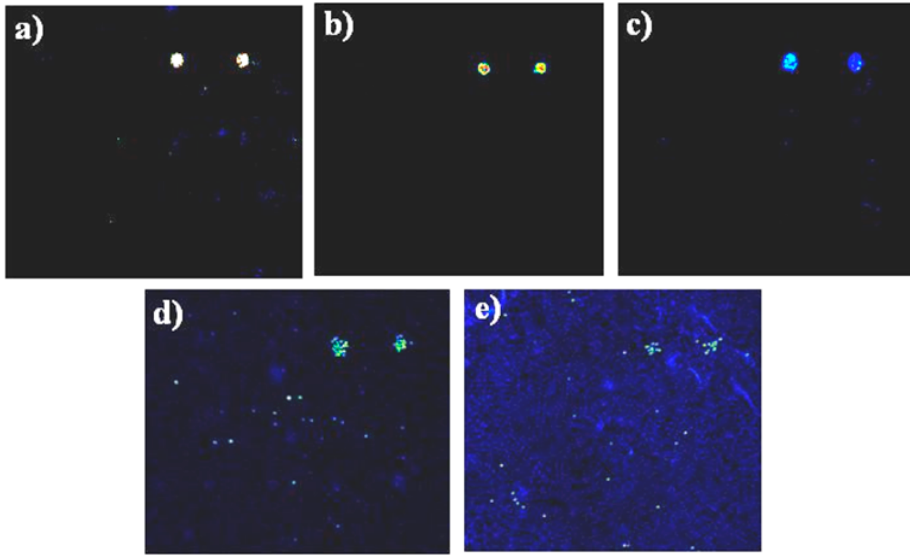
Figure 3. Assessing the limit of detection of protein chips using serial dilutions of Salmonella spp. Protein chips hybridised with serial dilutions of Salmonella cells after elution by thermal treatment of magnetic beads. Quantification of colony forming units performed in parallel by plating bacteria on XLD-Agar. Each sub-array was hybridised with a serial dilution of Salmonella , 10 6 cfu/mL. ( a ) 10 5 cfu/mL; ( b ), 10 4 cfu/mL; ( c ) 10 3 cfu/mL; ( d ) and 100 cfu/mL; ( e ) Signals obtained by direct labelling of bacteria with Alexa 646. Experiments were repeated at least three times. Size of subarrays: 3 × 3 mm.